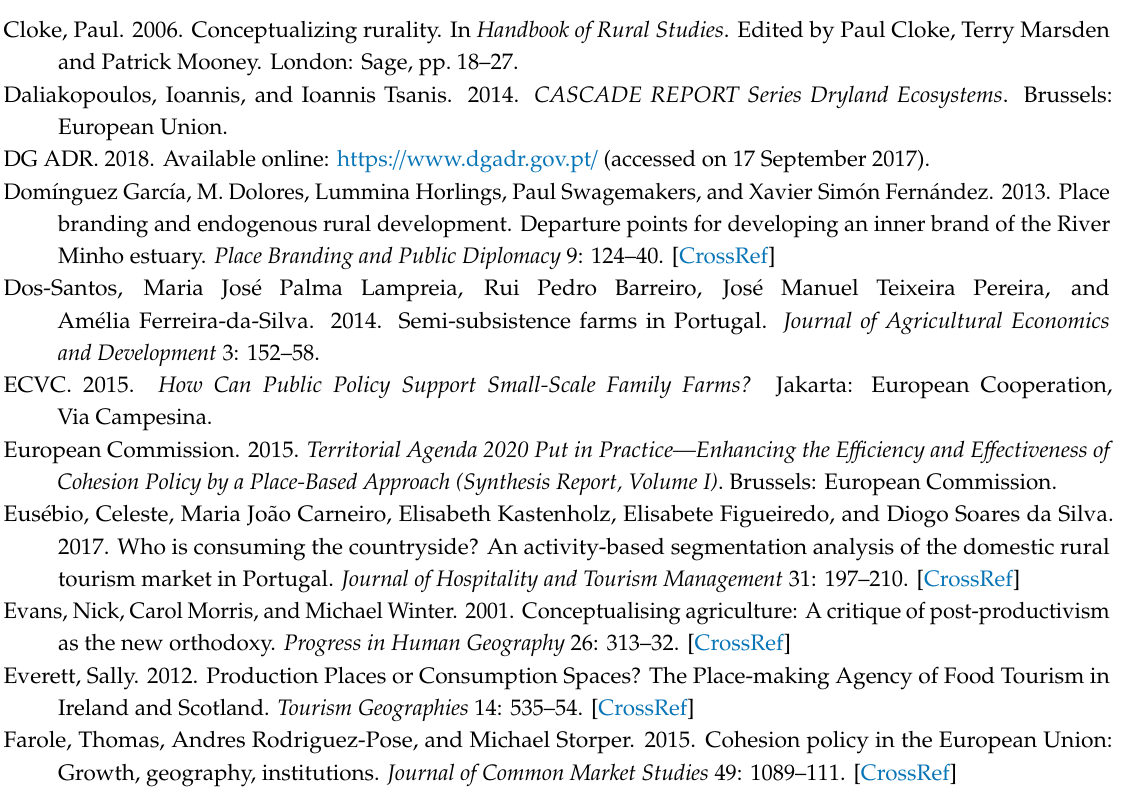
Figueiredo, Elisabete, and Antonio Raschi. 2013. Fertile Links? Connections between Tourism Activities, Socio-Economic Contexts and local Development in European Rural Areas . Florence: Firenze University